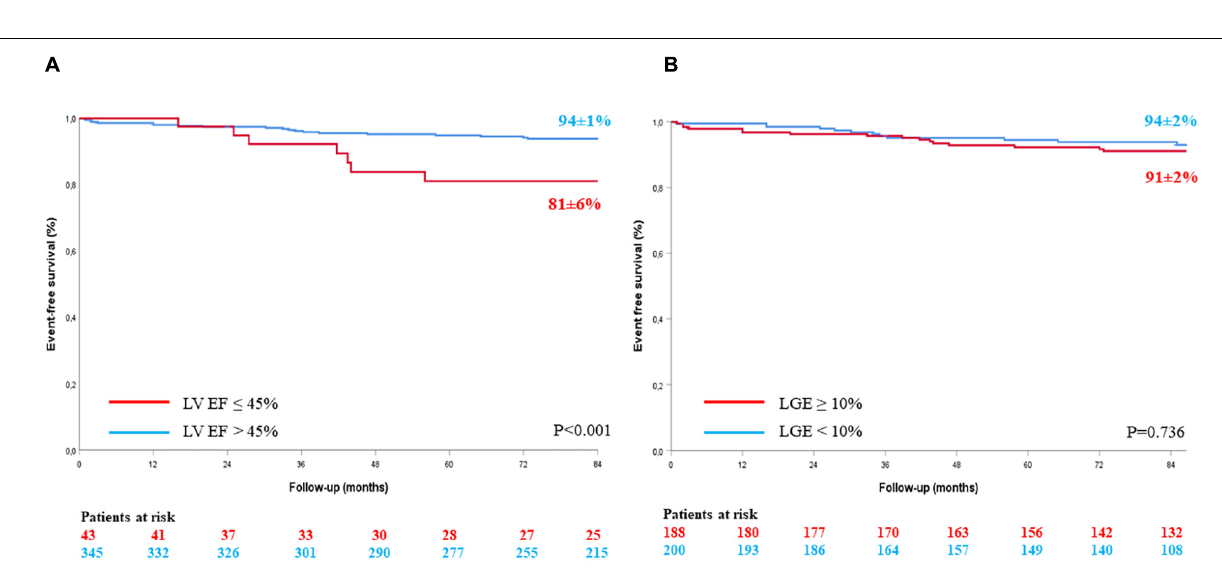
FIGURE 4 | Kaplan Meier event-free survival curves according to LV EF (A) and LGE extension (B) . LGE, late gadolinium enhancement; LV EF, left ventricular ejection fraction.